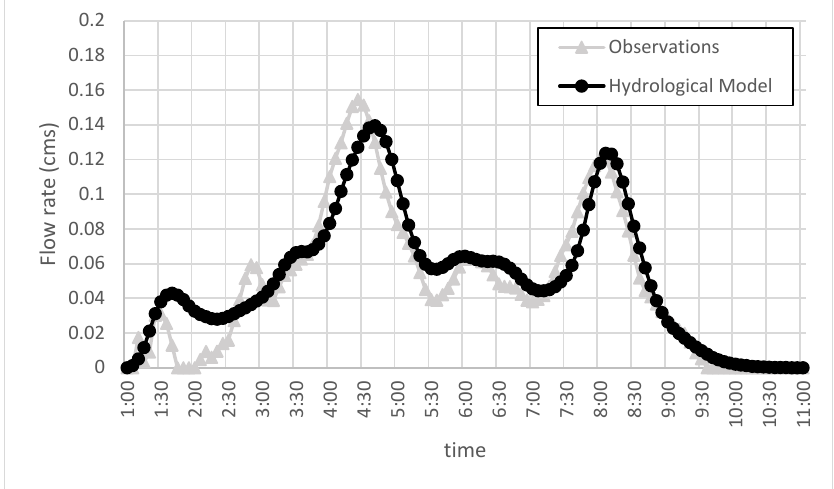
Figure 4. Modeled and observed hydrographs at I5 inlet of storm event on 12 September 2007.